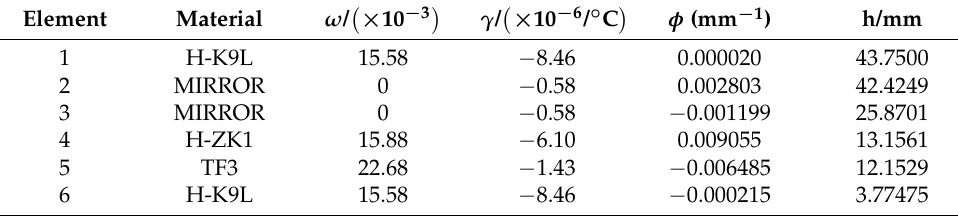
Table 3. Optical properties of the components in the final athermal optical system.